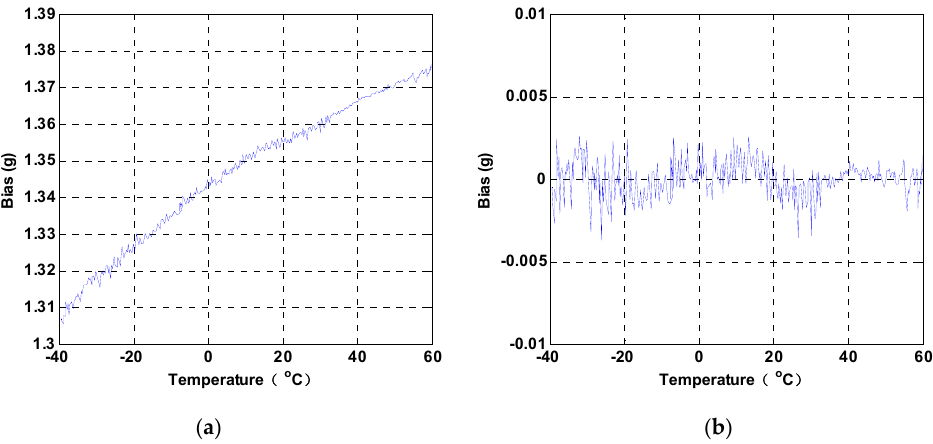
Figure 14. The bias of the SRA vary with the temperature. ( a ) Raw bias output. ( b ) Compensated bias output.